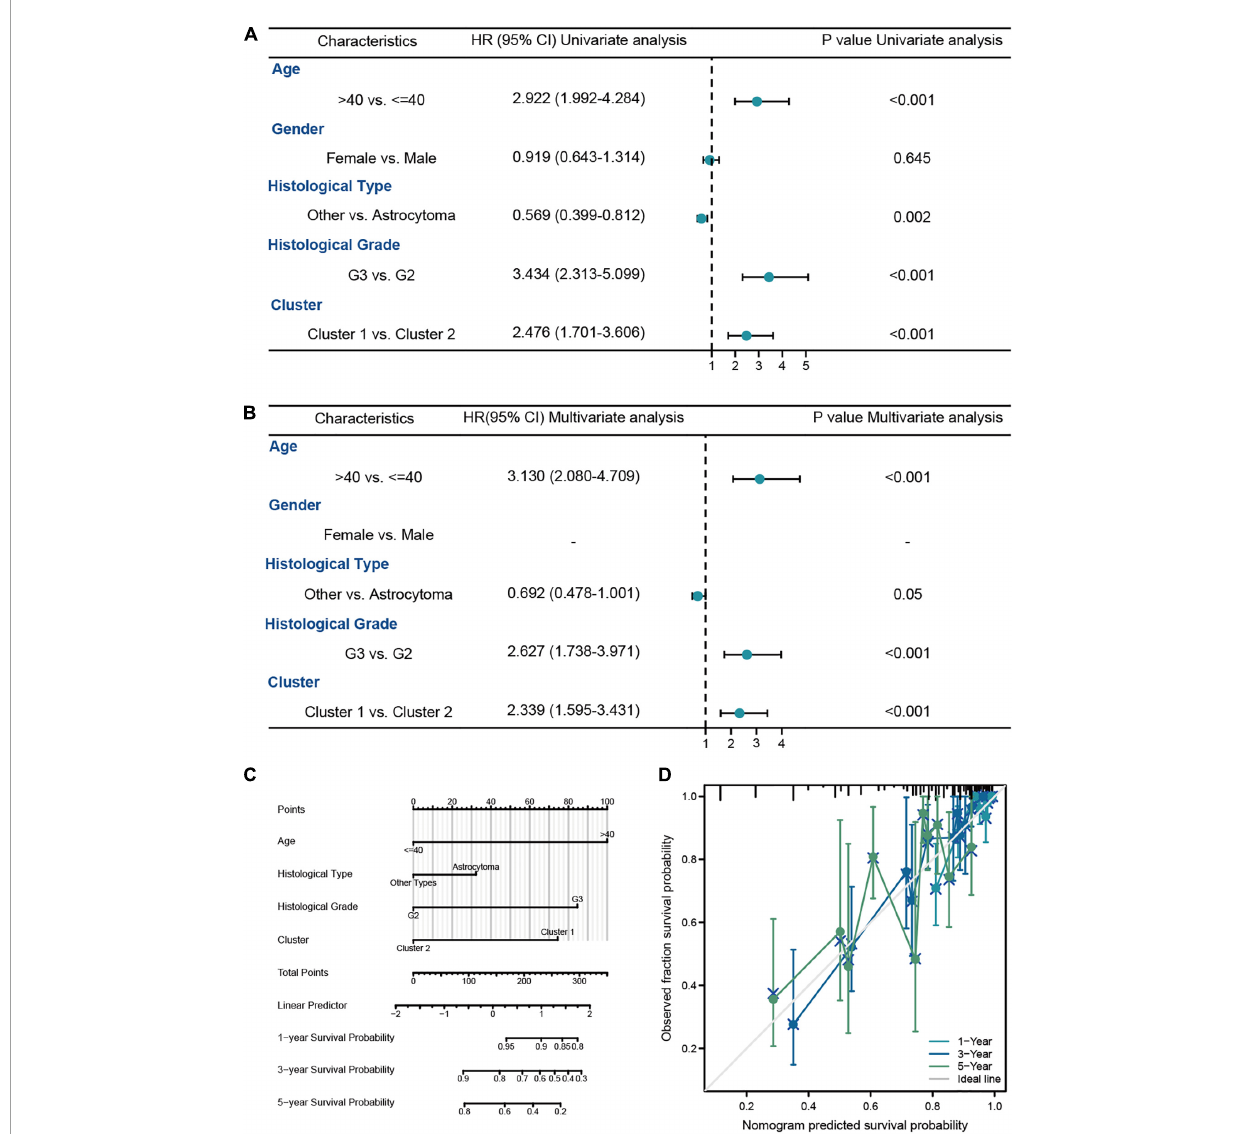
FIGURE7 The survival analysis of molecular subtypes in LGG patients from TCGA-LGG dataset. (A,B) The univariate and multivariate Cox regression analysis of OS in LGG patients from the training cohort. (C) The nomogram for the prediction of 1-, 3-, and 5-year OS in LGG patients. (D) Calibration plot of the nomogram in LGG